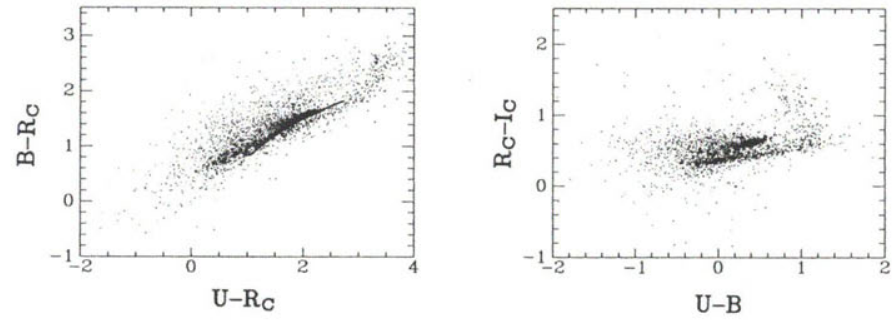
Fig. 15. Optical color-color relations for the Coma cluster. Symbols as in Fig. 14. Solid line on the left panel - SPP models from Vazdekis et al. (1996), see text.